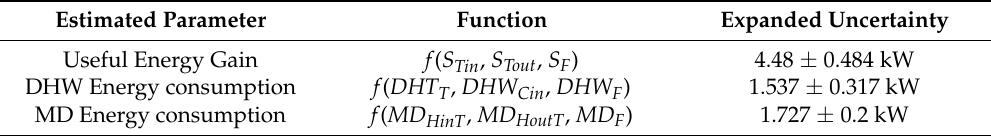
Table 4. Expanded uncertainty estimation.